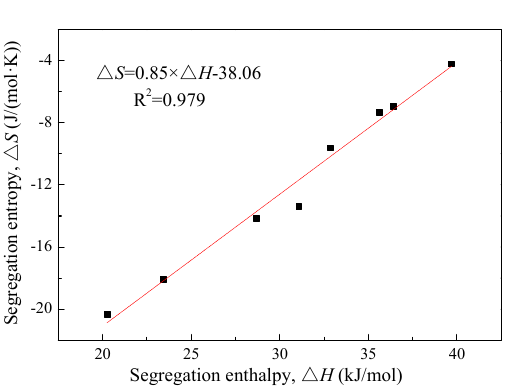
Figure 7. Unified relationship between phosphorus segregation entropy and enthalpy for both IF and 2.25Cr-1Mo steels.